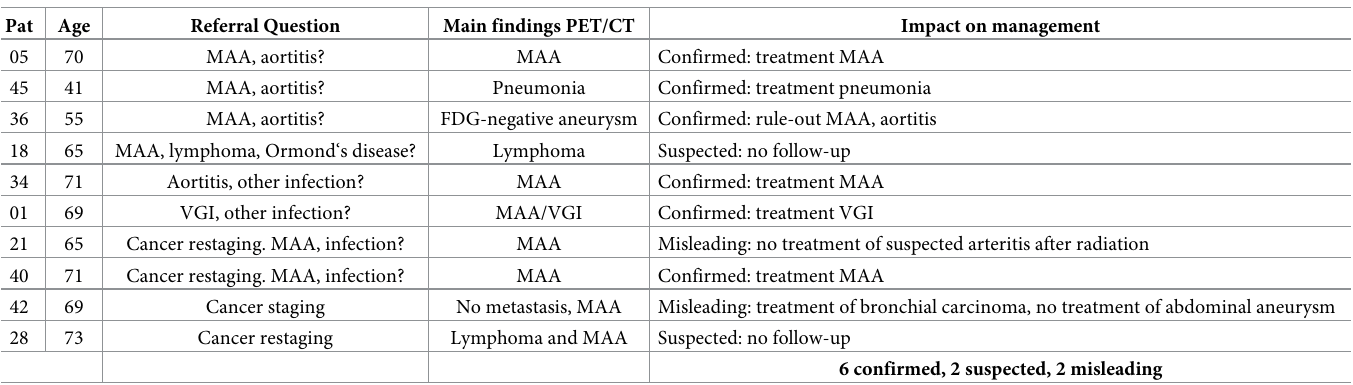
Table 5. Impact on patient management of baseline PET/CT scans with the various referral questions (n = 10). Pat